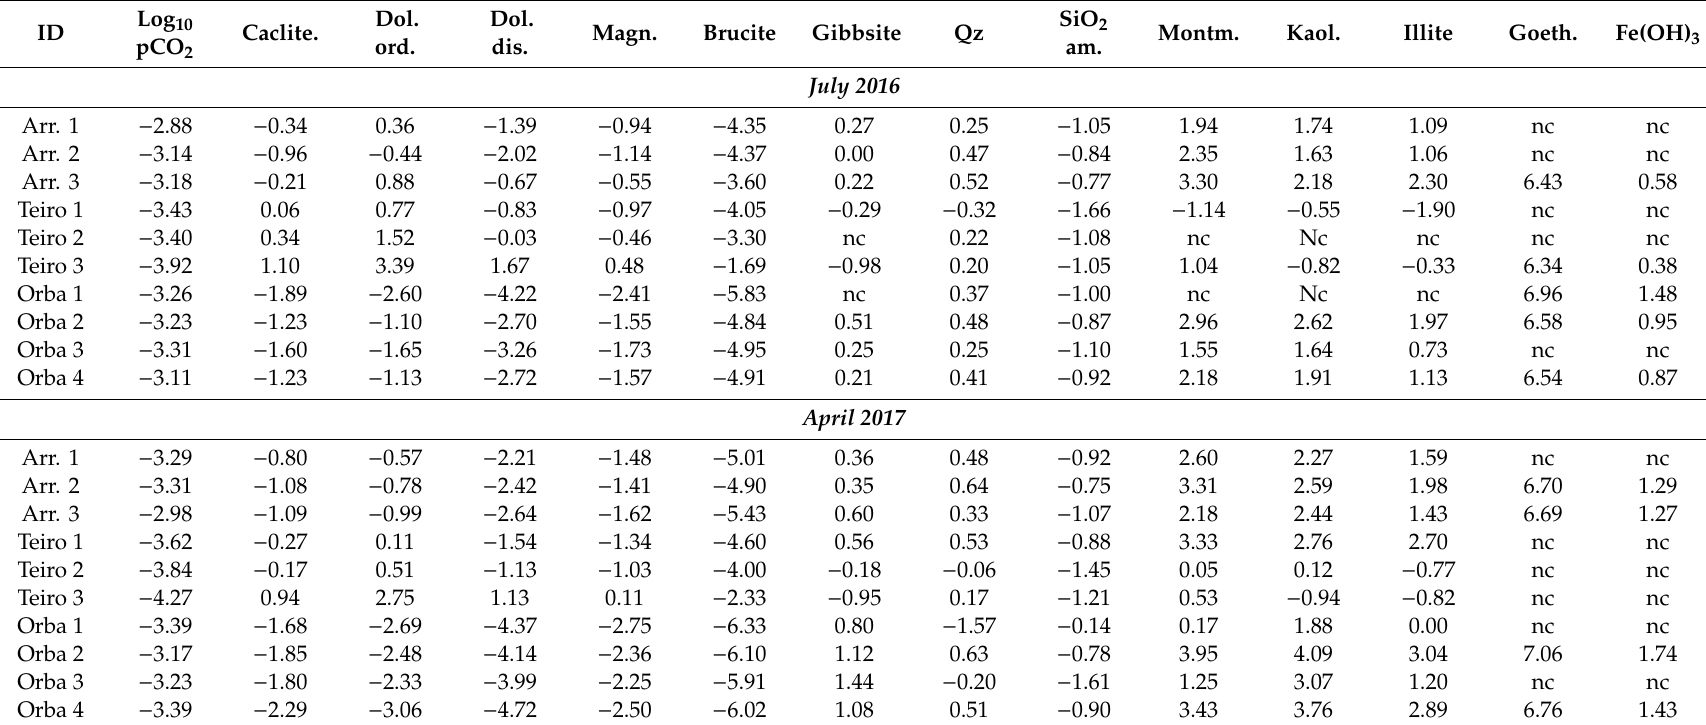
Table 3. Log 10 of the partial pressure of CO 2 and saturation